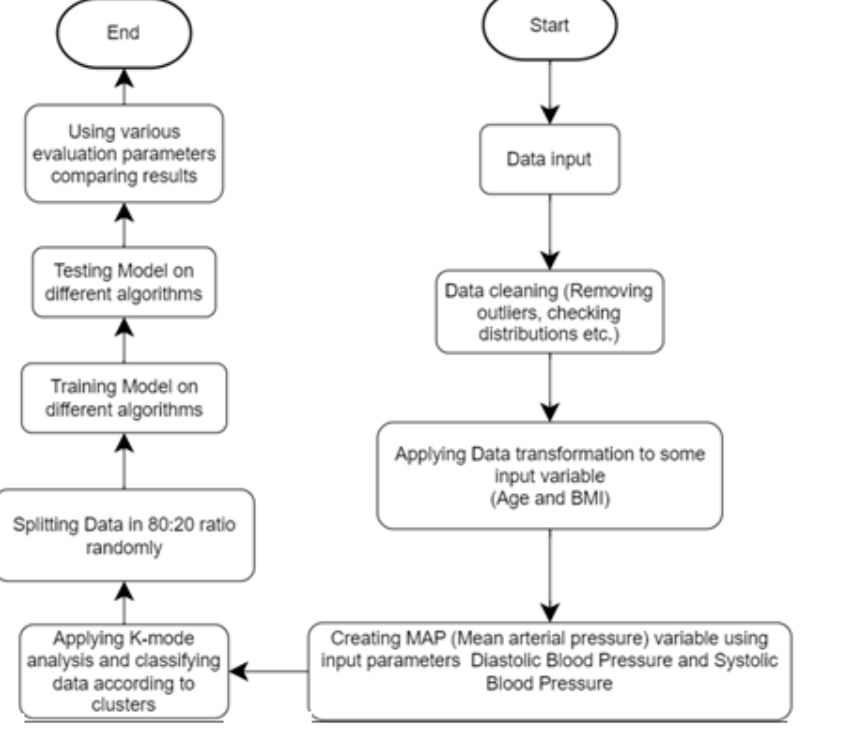
Figure 1. Flow diagram of Model. Table 2. Datasets